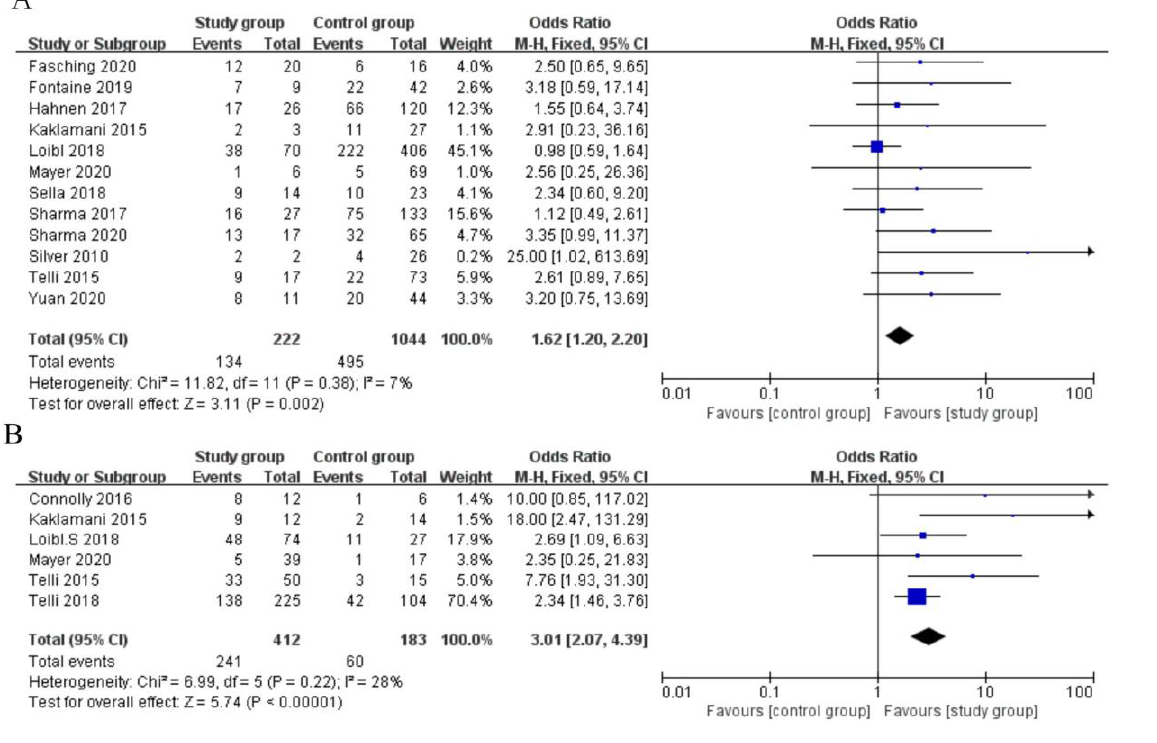
Figure 3. Forest plot for comparison of pCR rates: ( A ) patients with BRCA 1/2 mutation vs. patients with BRCA1/2 wildtype; ( B ) HRD-positive vs. HRD-negative patients in 6 HRD-predefined studies.